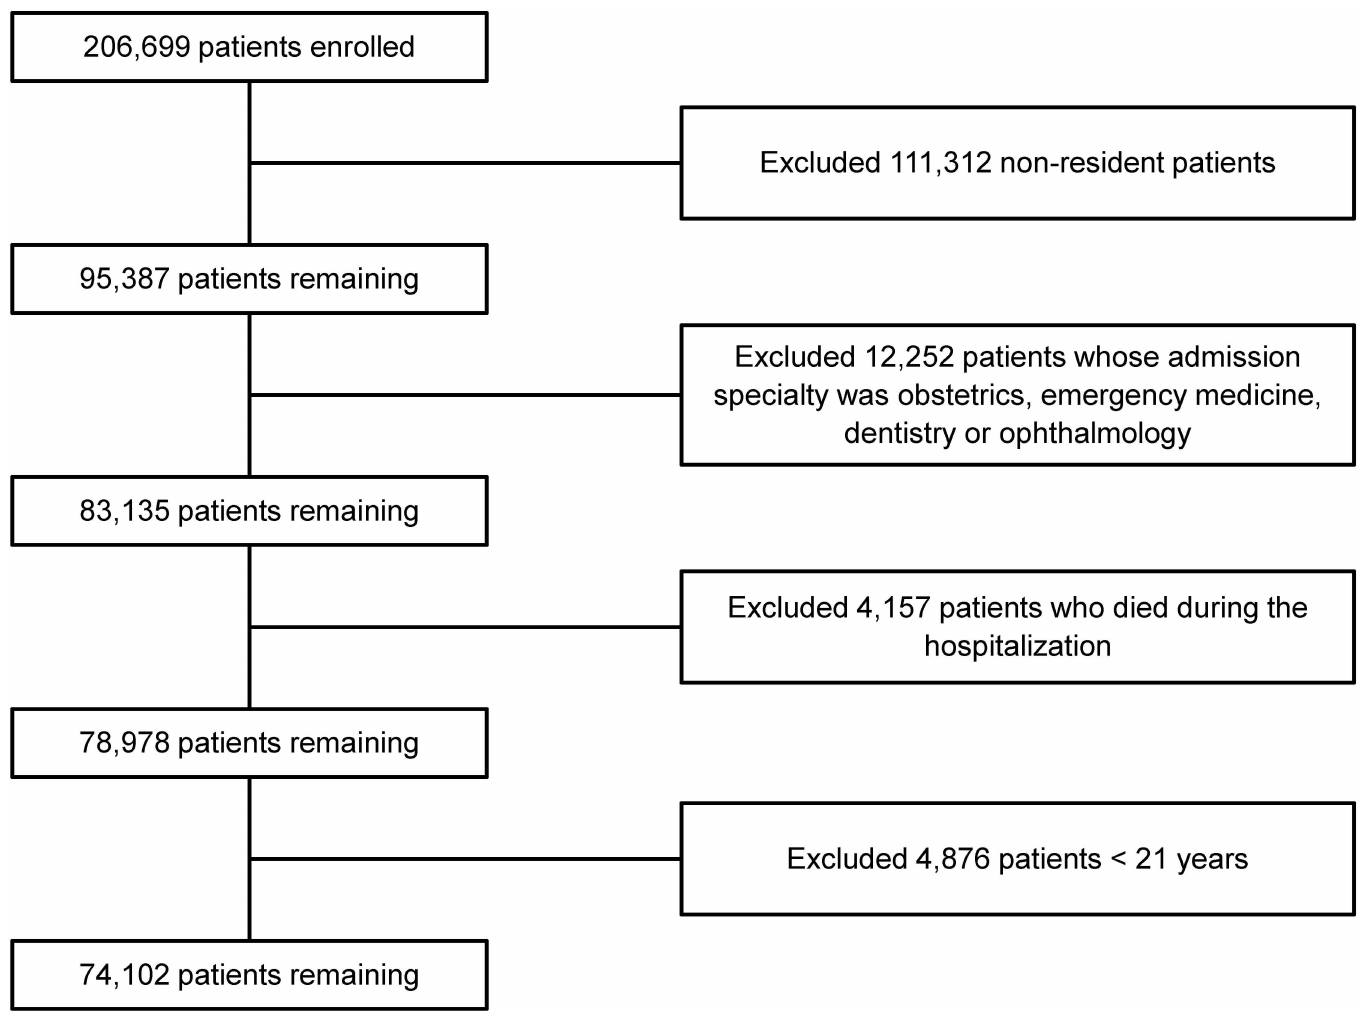
Fig 1. Study flow chart showing number of included, excluded, and readmitted